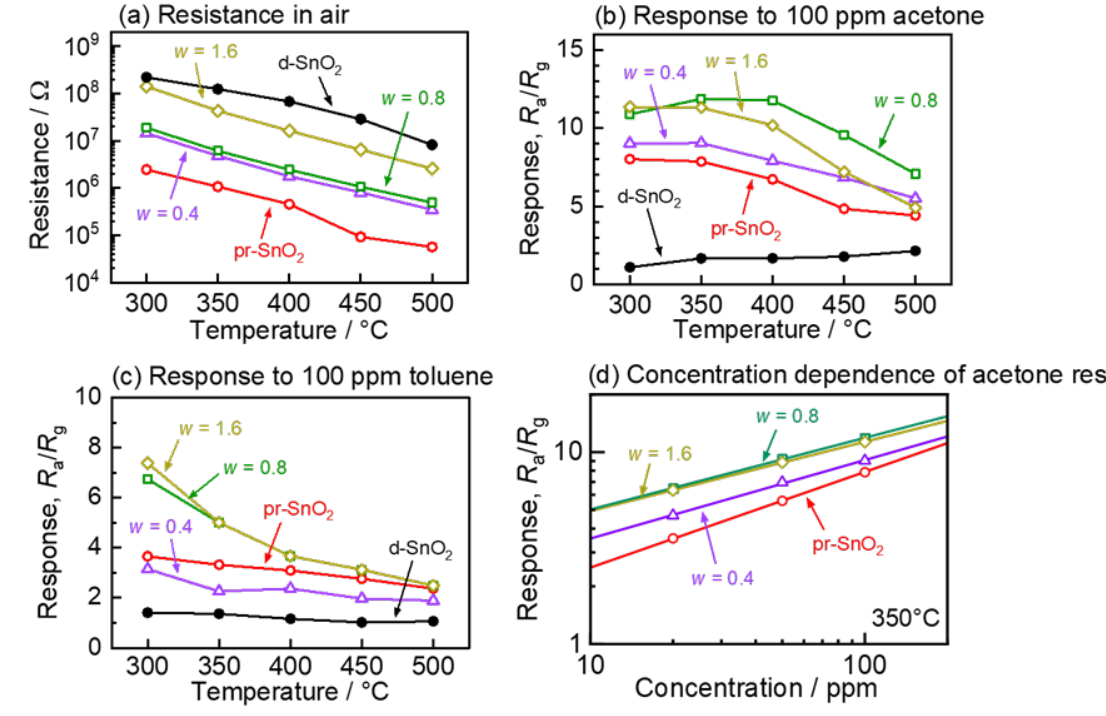
Figure 8. Temperature dependences of ( a ) resistances in air and responses to ( b ) 100 ppm acetone and ( c ) 100 ppm toluene of d-SnO 2 , pr-SnO 2 , and pr- w Cu-SnO 2 sensors, together with ( d ) concentration dependences of responses to acetone of pr-SnO 2 and pr- w Cu-SnO 2 sensors at 350 °C in air.